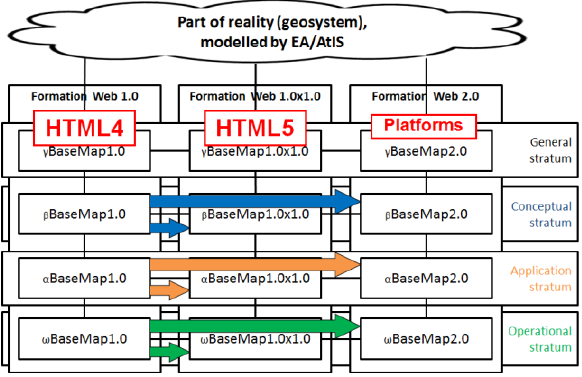
Figure 4. Formation-Strata projection of Web 2.0 ABM